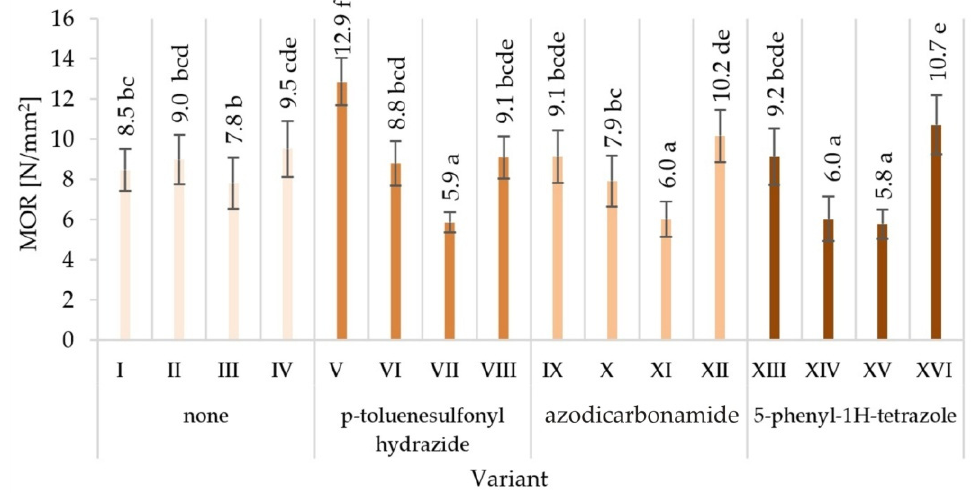
Figure 3. Static bending strength (MOR) of particleboards produced (means and standard deviation, a, b, c, . . . —homogeneous groups determined by the Tukey test; different letters denote a significant difference; means followed by the same letter do not statistically differ from each other).